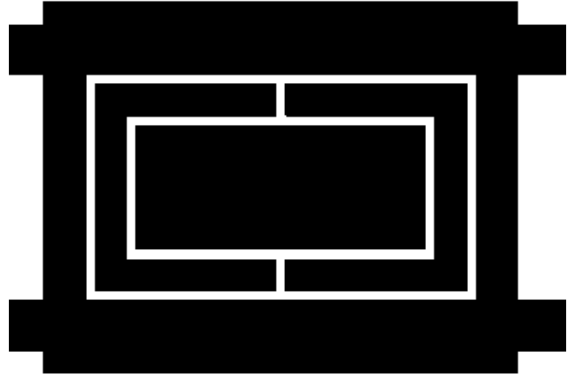
Fig.1. Design of the proposed dual-band coupler with rectangular patch